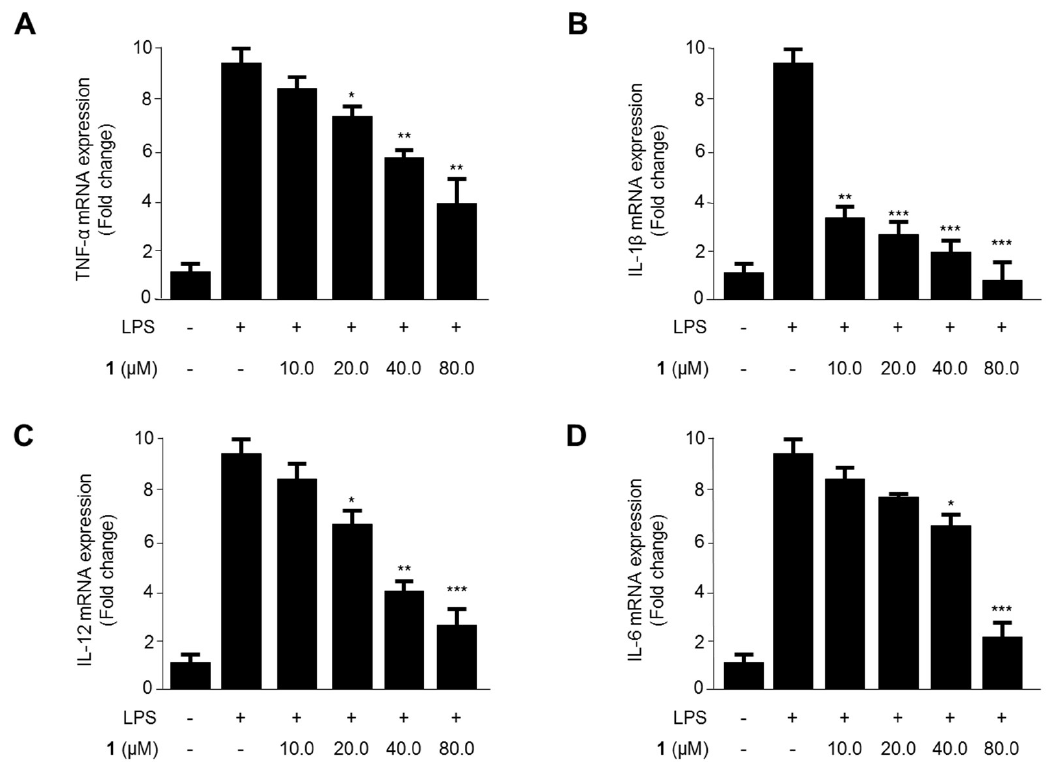
Figure 3. The effects of steppogenin ( 1 ) on the mRNA expression of tumor necrosis factor (TNF)- α ( A ), interleukin (IL)-1 β ( B ), IL-12 ( C ), and IL-6 ( D ) in lipopolysaccharide (LPS)-stimulated BV2 microglial cells. ( A – D ) The cells were pretreated for 3 h with the indicated concentrations of 1 and then stimulated for 12 h with LPS (1 µ g/mL). The data are presented as the mean ± SD of three experiments. * p < 0.05; ** p < 0.01; *** p < 0.001 compared with the LPS-treated